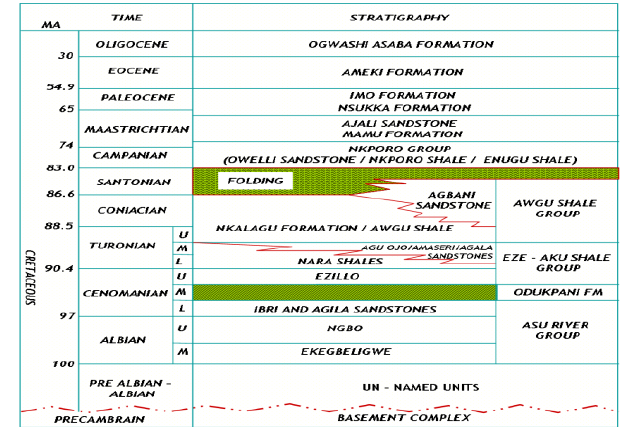
Table 1: Lithostratigraphic framework for the Early Cretaceous-Tertiary period in southeastern Nigeria. (after Nwajide,